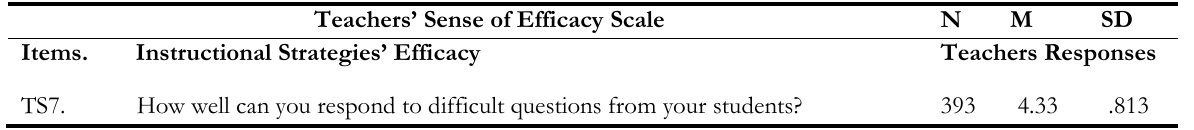
Table 2: Descriptive Statistics for 2 nd Factor of Teachers’ Sense of Efficacy Teachers’ Sense of Efficacy Scale N M SD Items. Instructional Strategies’ Efficacy Teachers